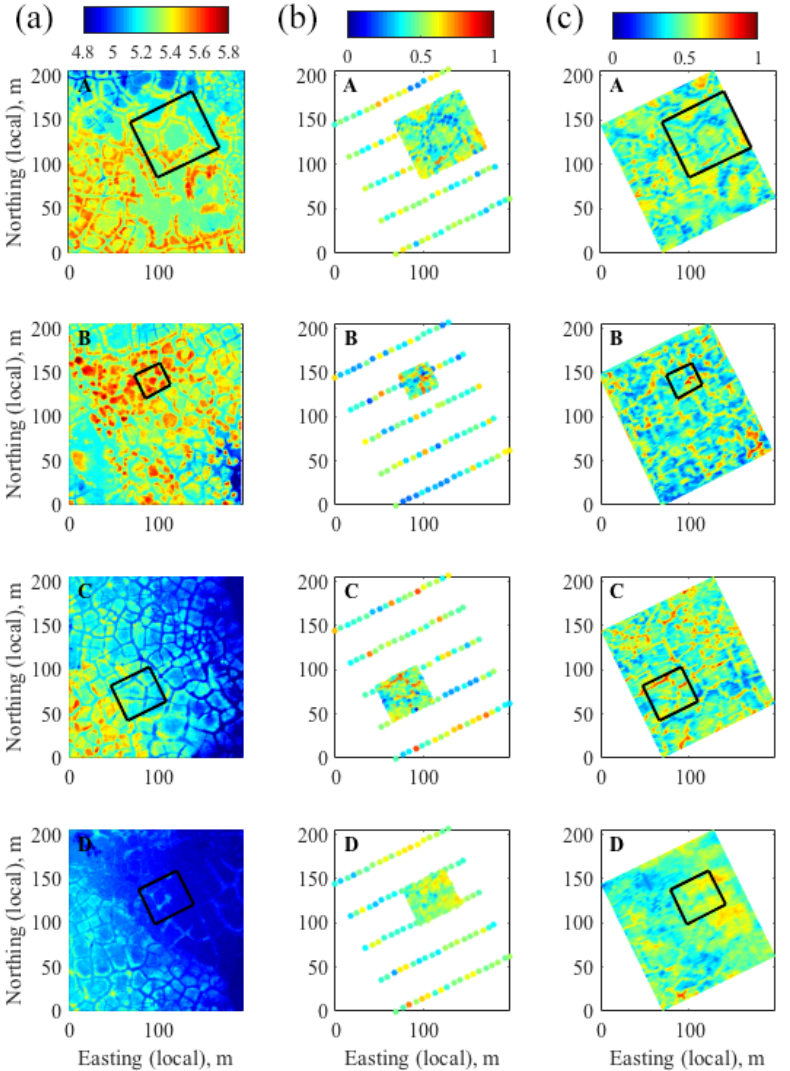
Figure 3. Elevation and snow depth in plots A, B, C and D. Panel (a) is lidar DEM (in meters), panel (b) is the probe measured snow depth (in meters), and panel (c) is the interpolated snow depth estimated using GPR (in